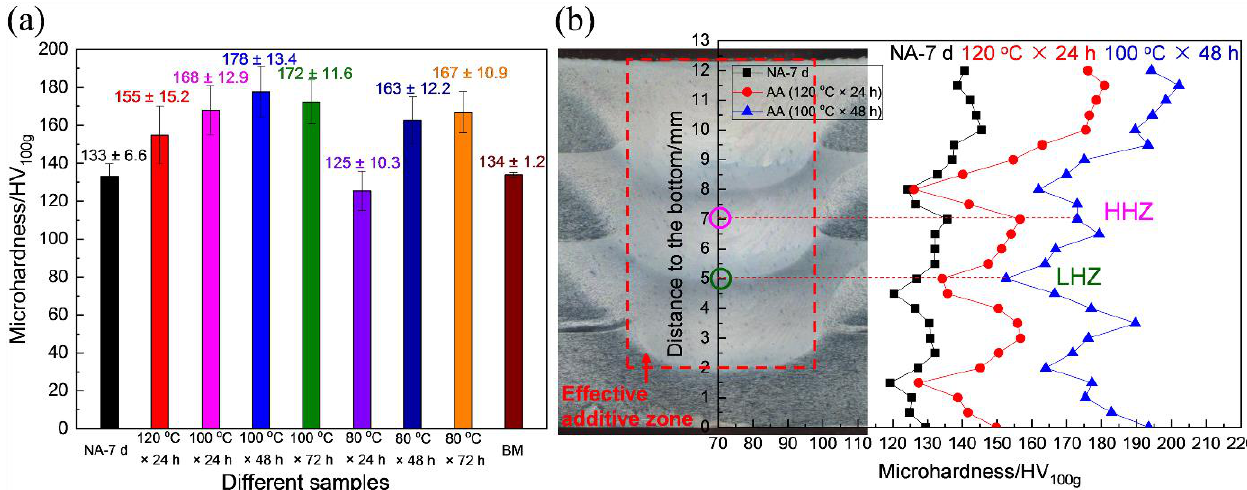
Figure 2. Microhardness of the builds in different aging states: ( a ) average microhardness values of the builds in different aging states; ( b ) microhardness distributions on the cross-section of the builds along the building direction in the NA-7 d, 120 °C × 24 h, and 100 °C × 48 h states. The typical samples of NA-7 d, 120 °C × 24 h, and 100 °C × 48 h were selected to